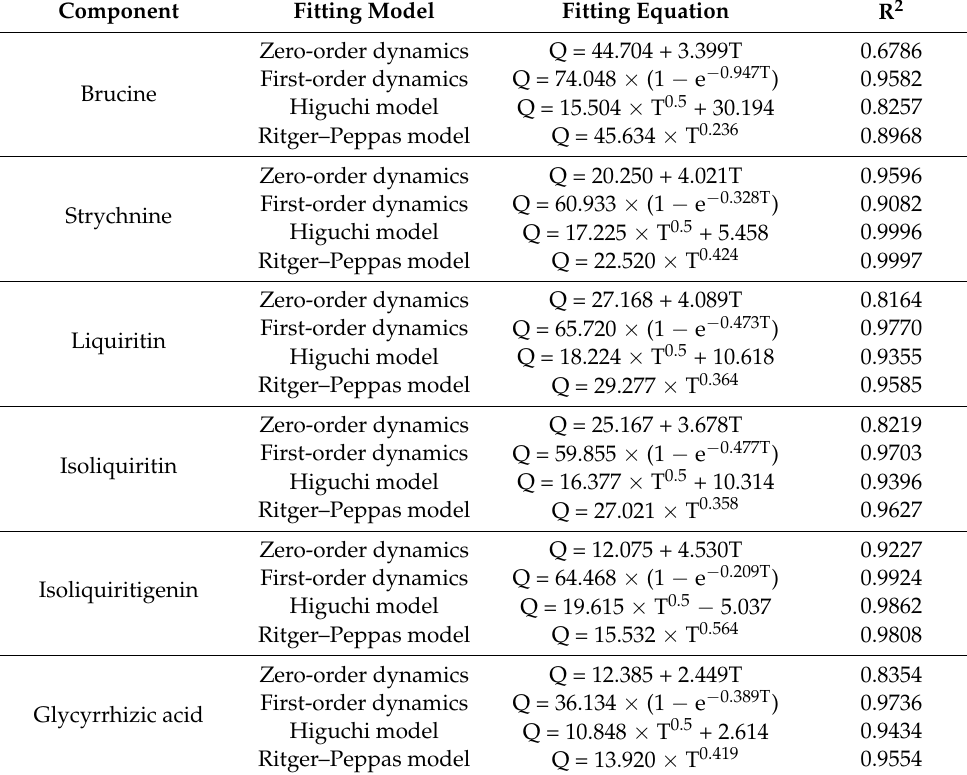
Table 8. Results of cumulative release fitting in artificial gastric